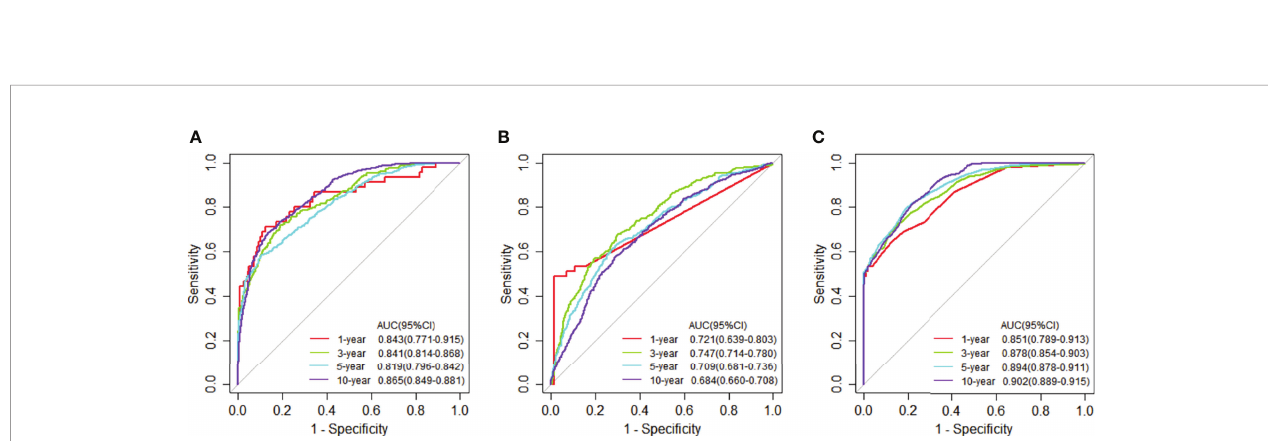
FIGURE 5 | The gene – gene interaction network in TCGA. The selected interaction networks for (A) 1-year, (B) 3-year, (C) 5-year, and (D) 10-year categories. The orange circular nodes represent hub genes.